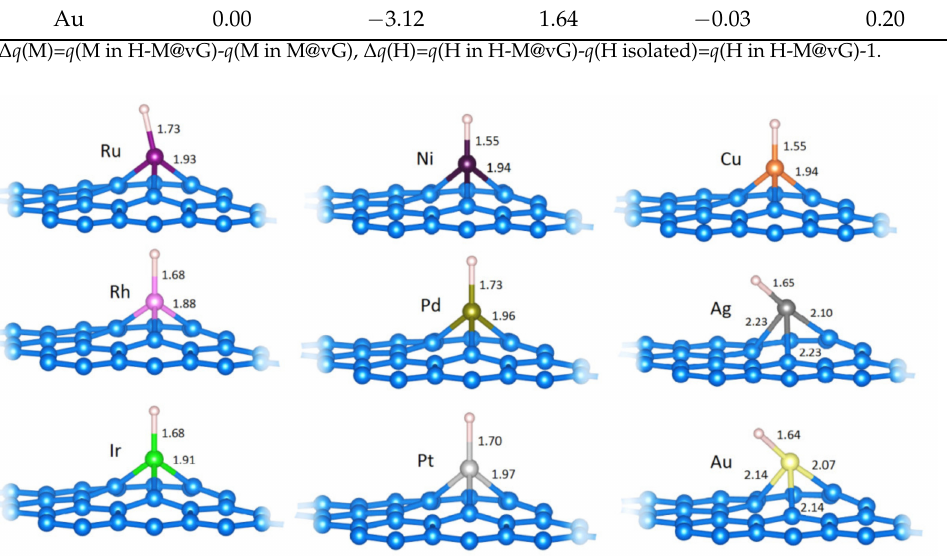
Figure 4. The relaxed structures of H@M-top on C 31 M systems (M is labeled for each structure). M − H and C − M bond lengths are given in Å (if all C − M bonds are of equal length, only one such length is indicated). Structural models were made using VESTA